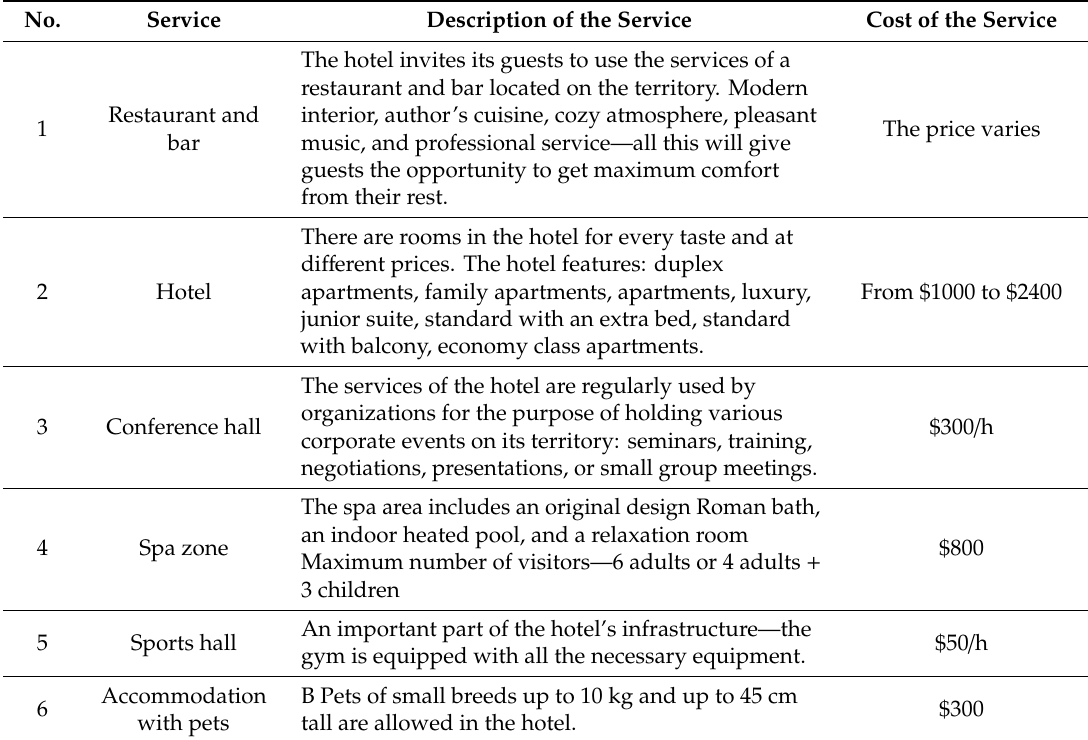
Table 3. Information about the services of the hotel-restaurant “HOTEL AND RESTAURANT PREMIUM CLUB”.